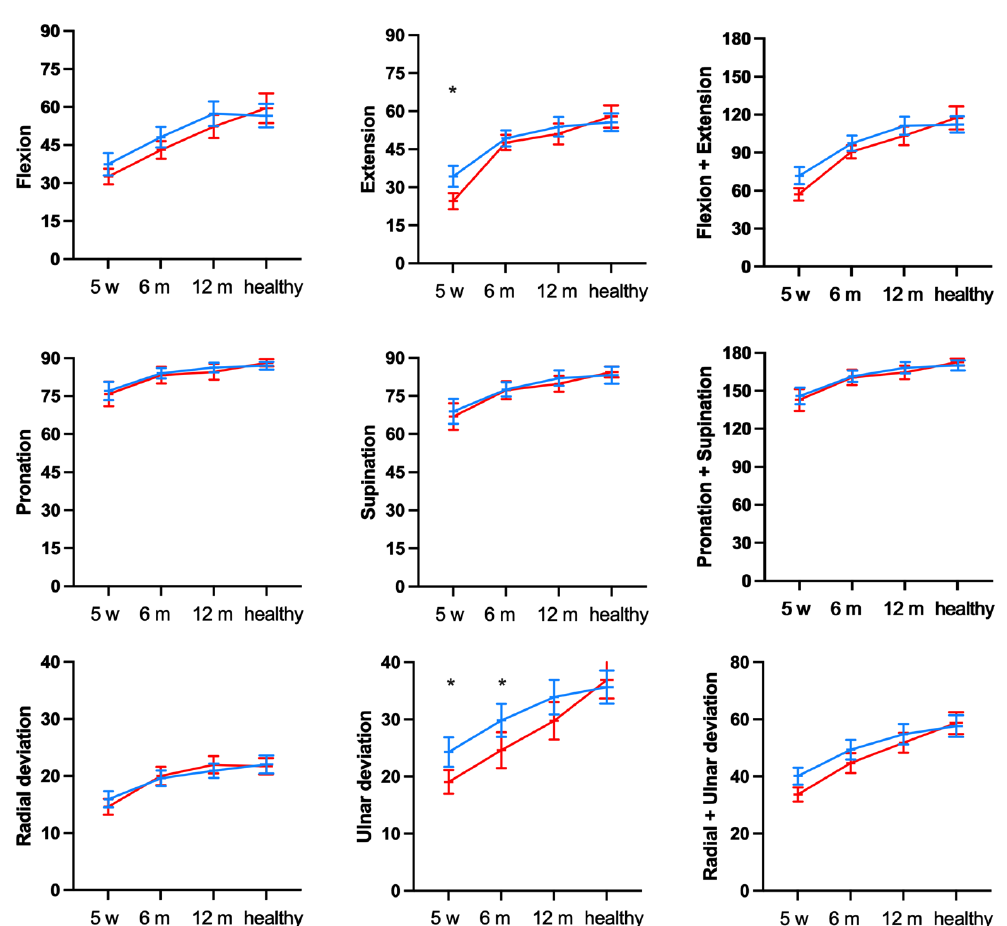
Figure 4. Mean range of motion of wrists with displaced (red) and minimally/non-displaced (blue) DRF at 5 weeks (w), 6 and 12 months (m) compared with the uninjured/healthy side. Error bars represent 95% confidence intervals. * p < 0.05.